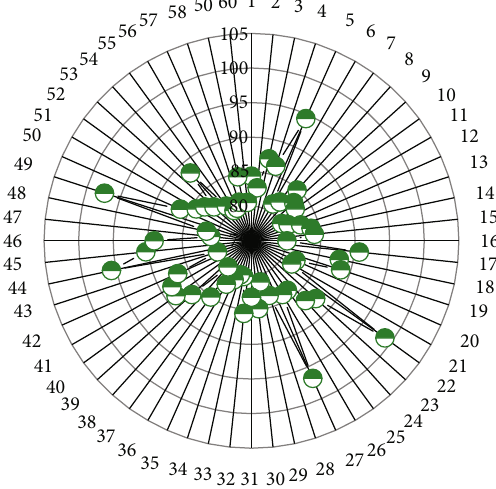
Figure 4: Distribution of readers ’ preference for Japanese